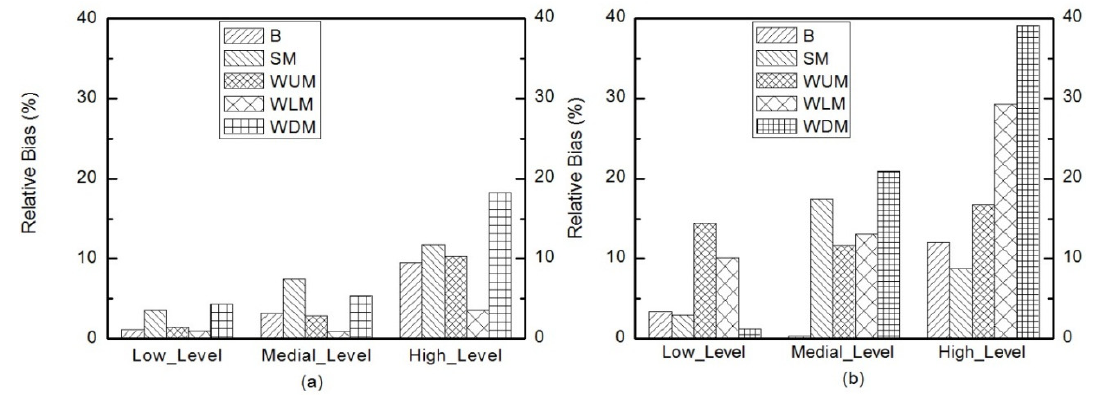
Figure 7. Comparison between the the EnKF method ( a ) andSCE-UA method ( b ) for parameter estimation.